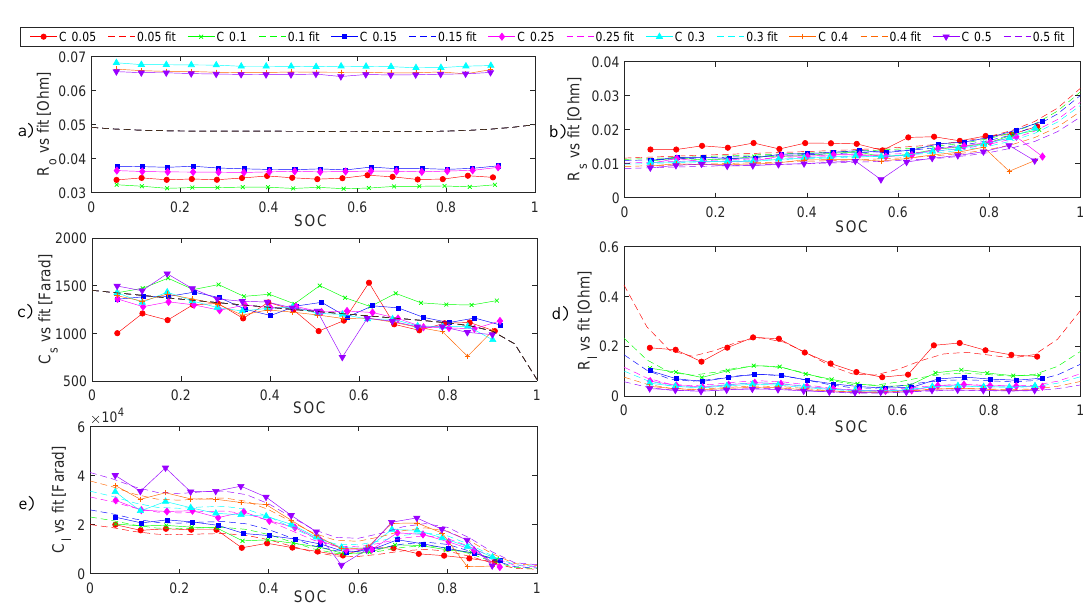
Figure 10. The values of RC elements and their fitted results: LFP batteries during charge.